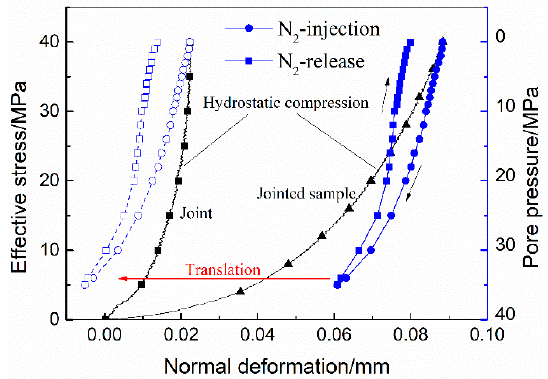
Figure 6. The relative normal deformation of jointed sample during N 2 injection and release.